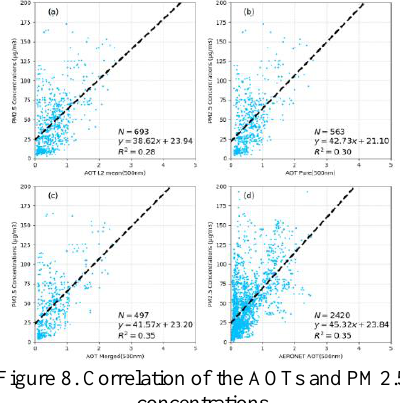
Figure 8. Correlation of the AOTs and PM2.5 concentrations